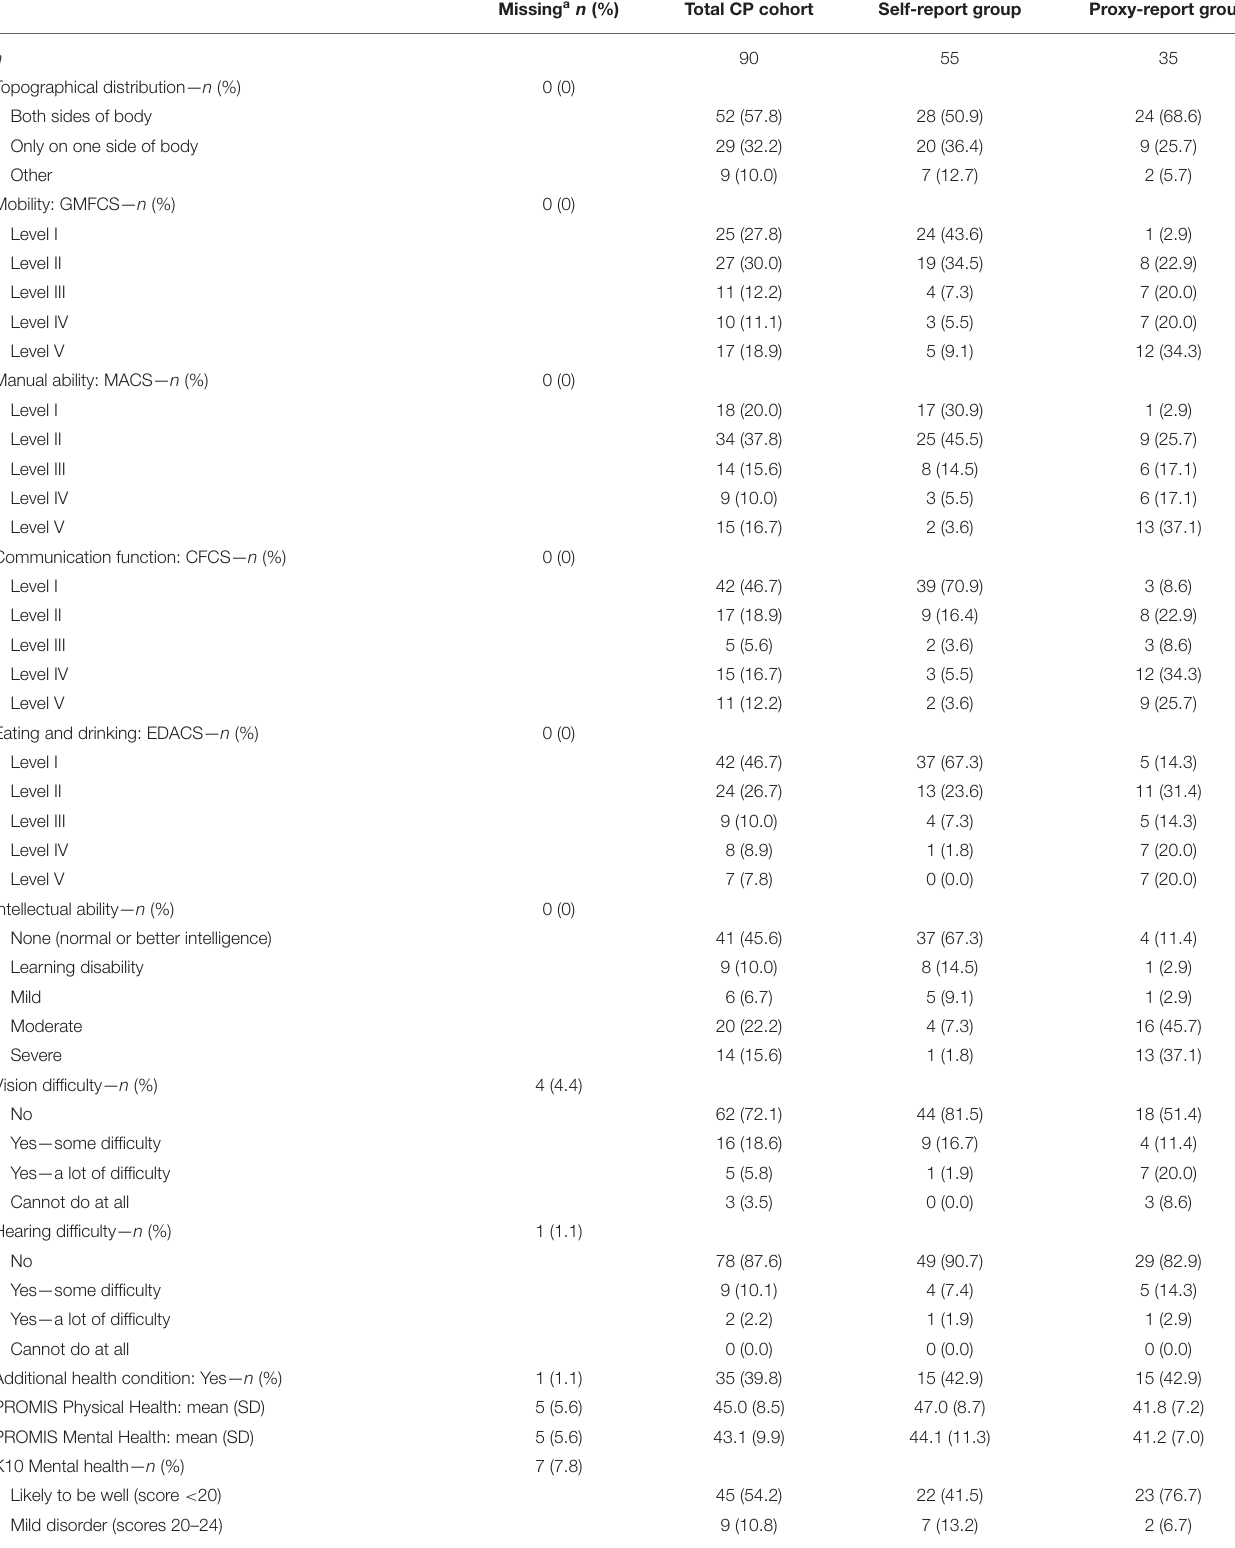
TABLE 2 | Characteristics of the CP cohort by survey reporting status. Missing a n (%) Total CP cohort Self-report